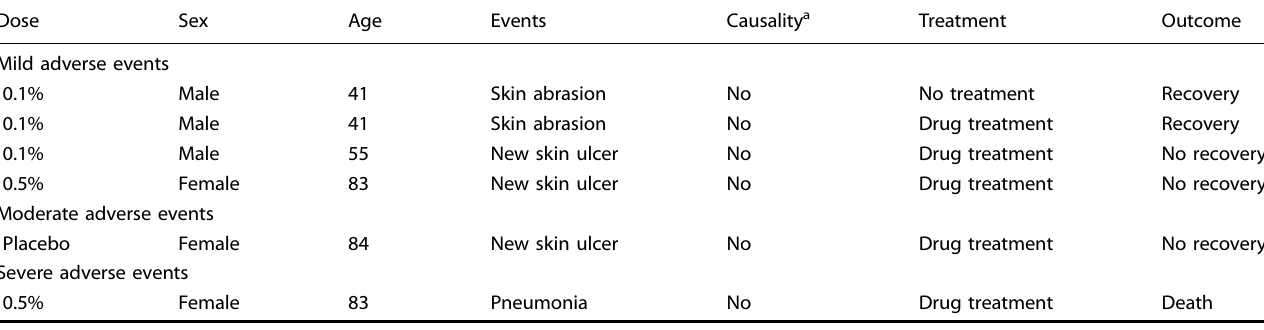
Table 4. List of all adverse